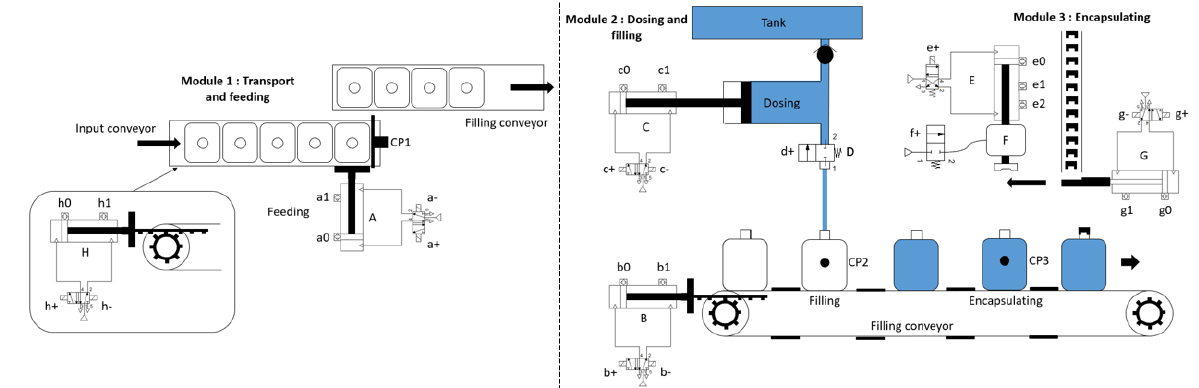
Figure 6. Schematic representation of the filling and encapsulating machine.